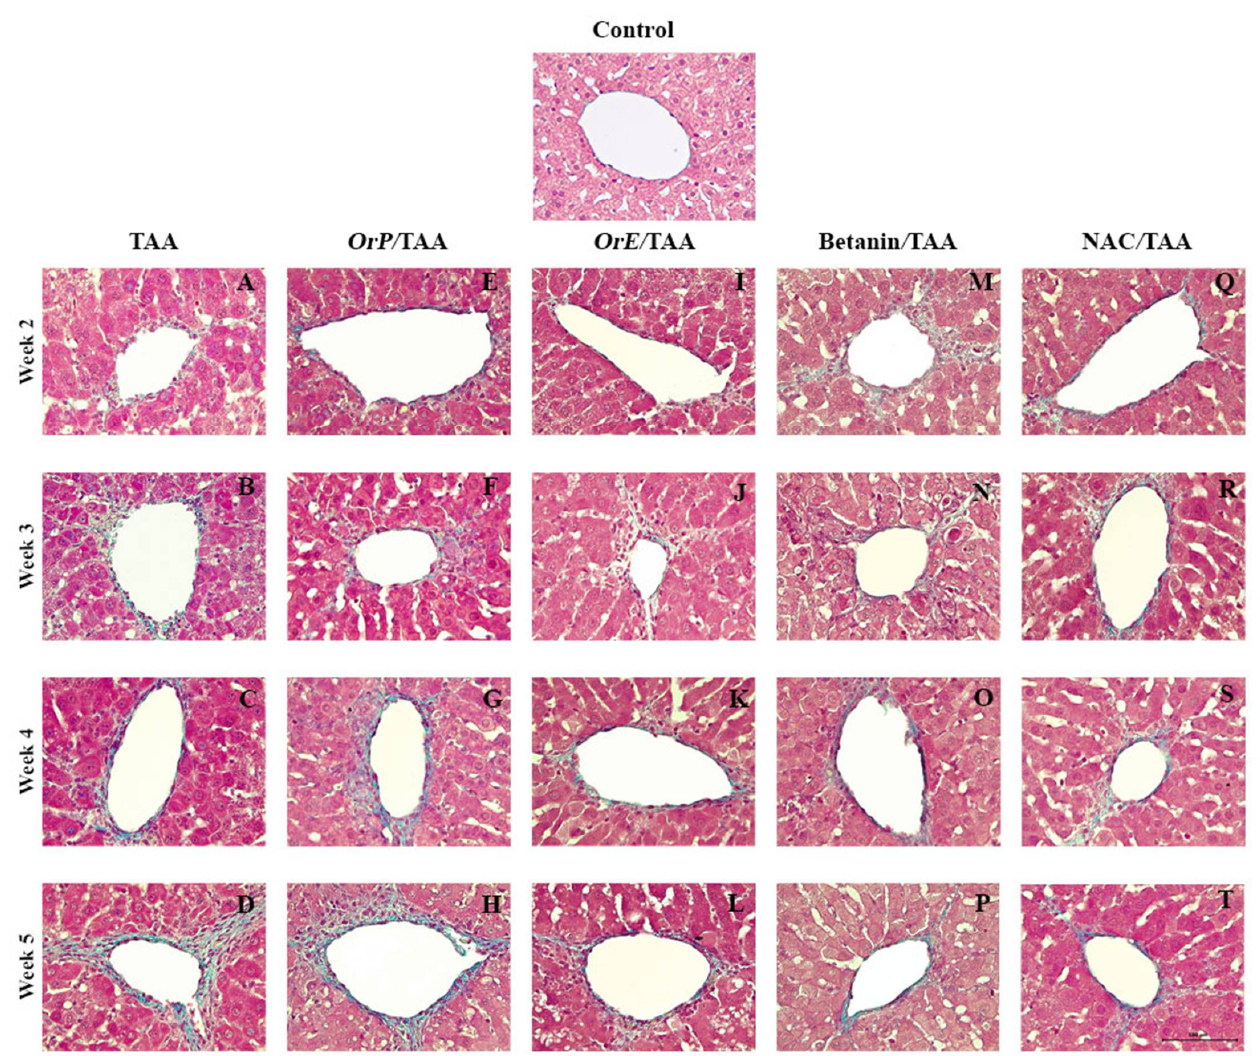
Figure 8. Effect the hepatoprotectors on histopathology in TAA-induced liver damage through time. ( A – D ) Necrosis and fibrosis septa are shown in zone 3 of the hepatic acinus with TAA administration. ( E – T ) Treatments with OrP , OrE , Betanin, and NAC decrease the number of damaged cells and the thickness of collagen septa. Masson’s trichrome staining. Magnification: 400×. MDA